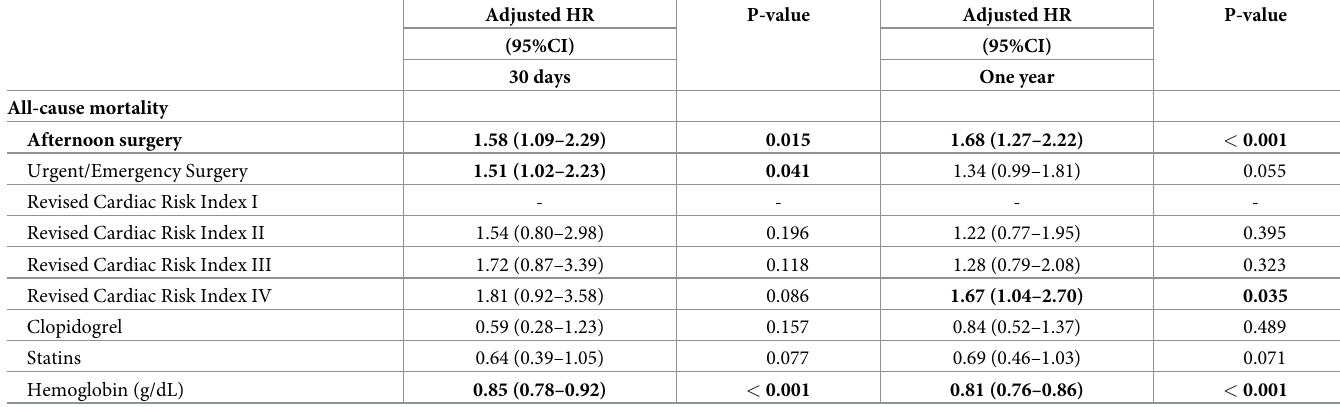
Table 3. Multivariable analysis by Cox regression model—All-cause mortality.